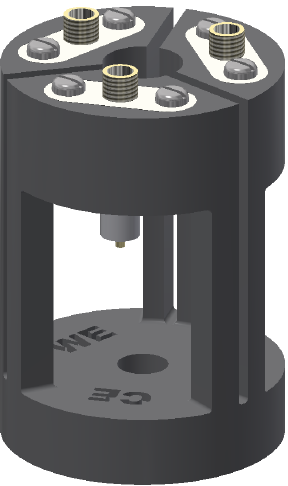
Figure 2. Cell holder consisting of the 3D-printed frame (black) and three SMA coaxial connectors (white and gold). The electrol- ysis cell is fixed inside the cell holder and the electrode wires are soldered to the pins of the SMA coaxial